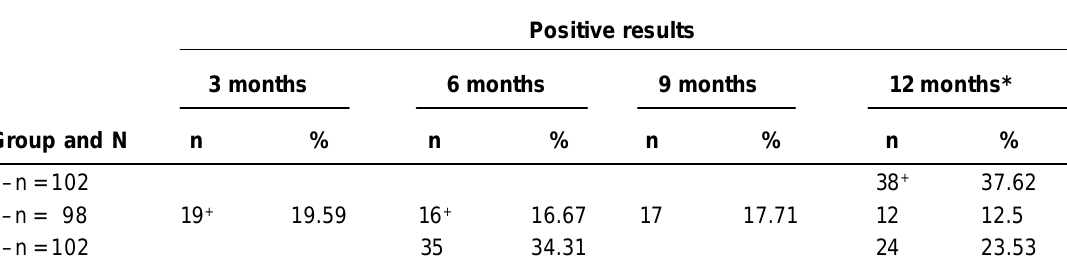
Positive Results, by Study Group, for E. histolytica Cysts in Parasitoscopic Samples Positive